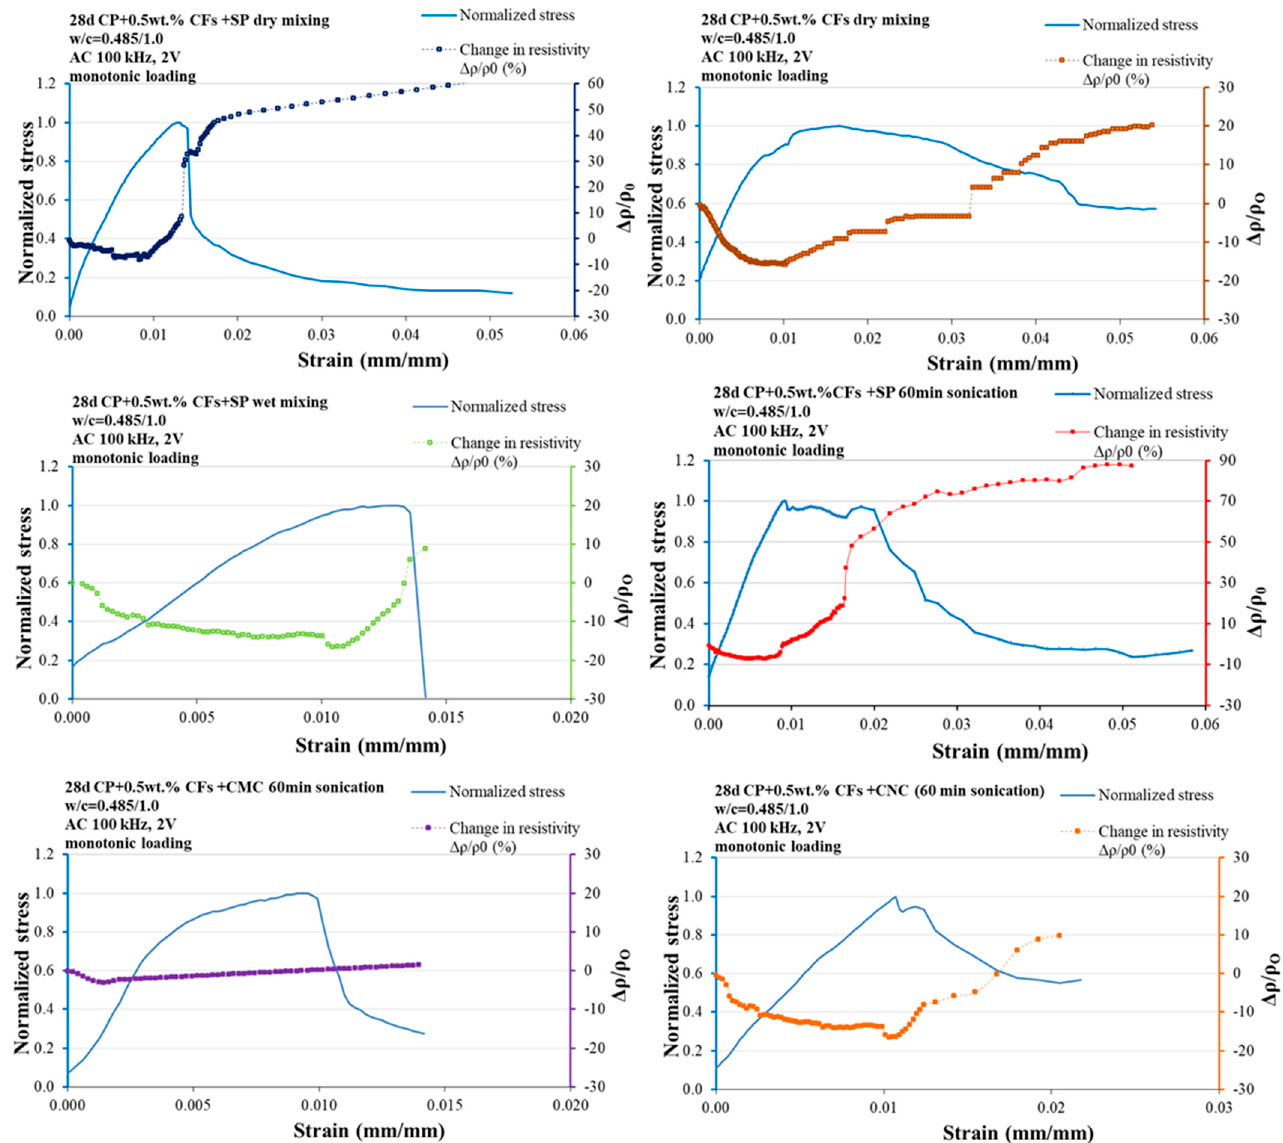
Figure 10. Piezoresistive behavior under monotonic loading of 28-d plain and reinforced cement paste composites with CFs incorporated by different methods.